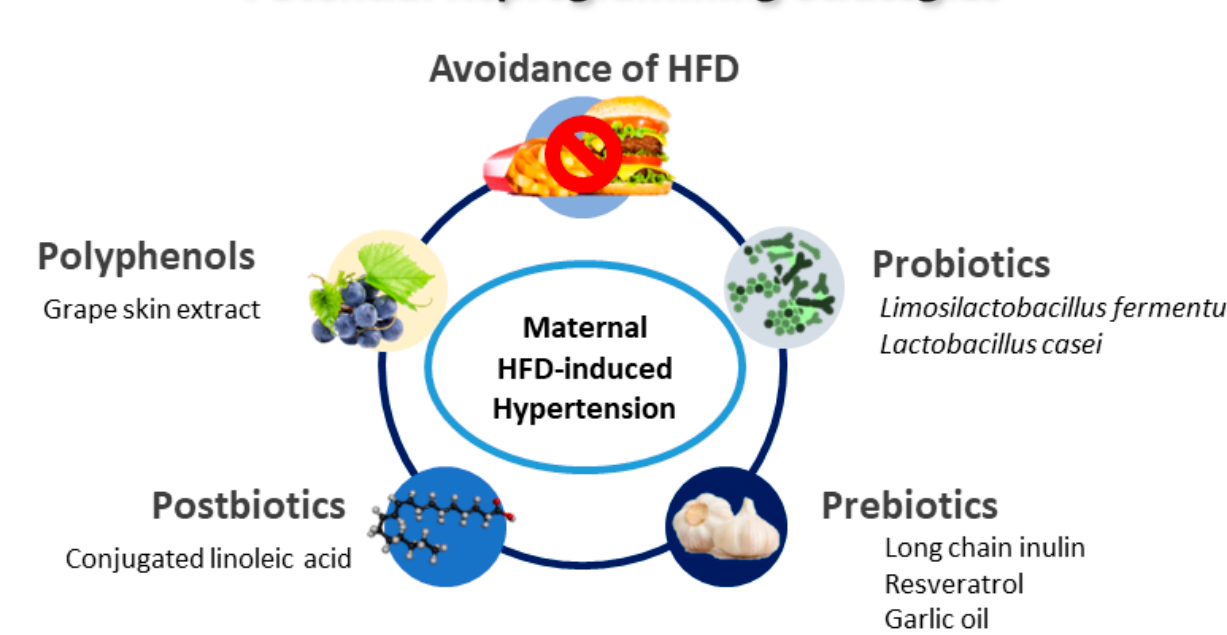
Figure 3. Schematic diagram of the potential reprogramming strategies for prevention of maternal high-fat-diet-induced offspring hypertension.